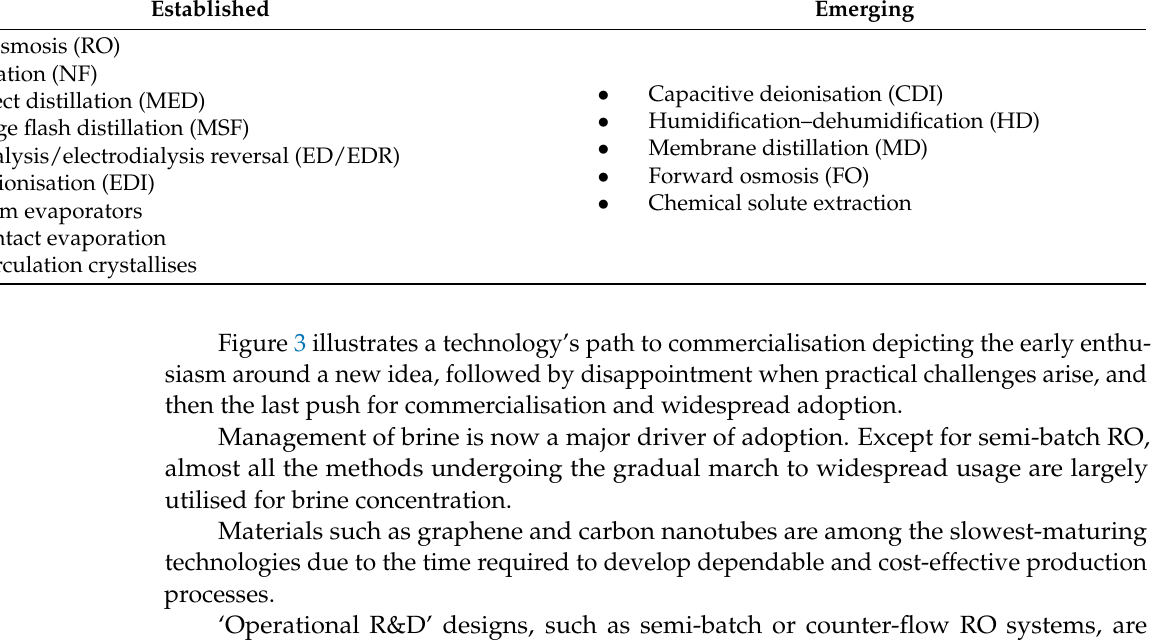
Table 2. Industrial solar desalination technologies classifications. Established